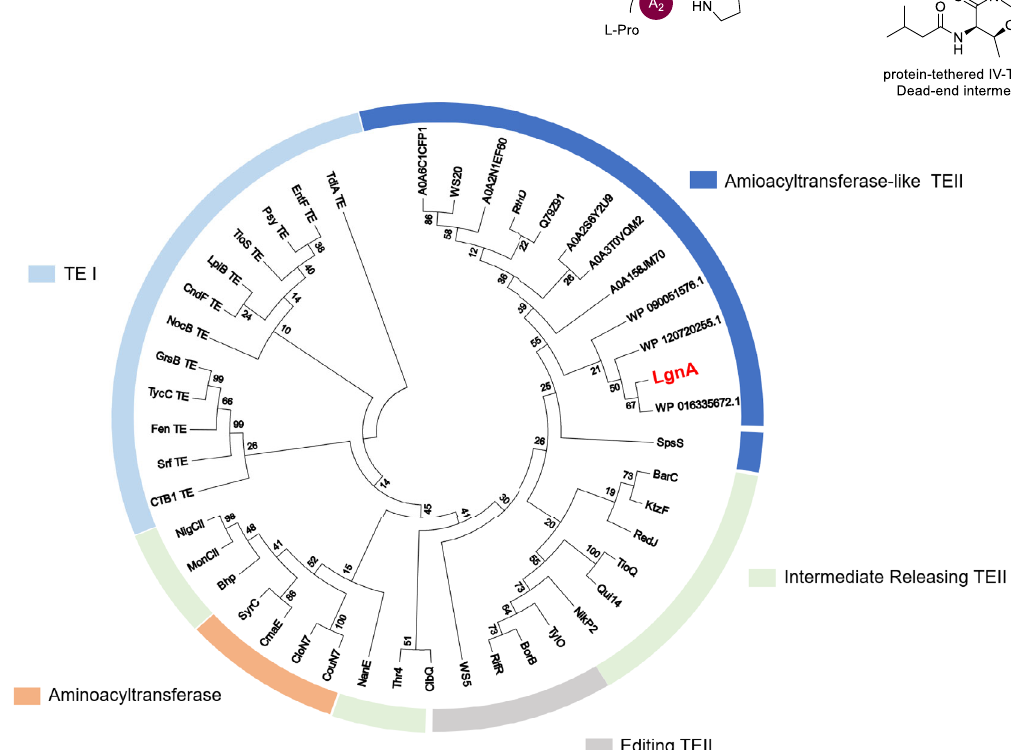
NATURE COMMUNICATIONS| (2022) 13:62 |https://doi.org/10.1038/s41467-021-27512-0|www.nature.com/naturecommunications